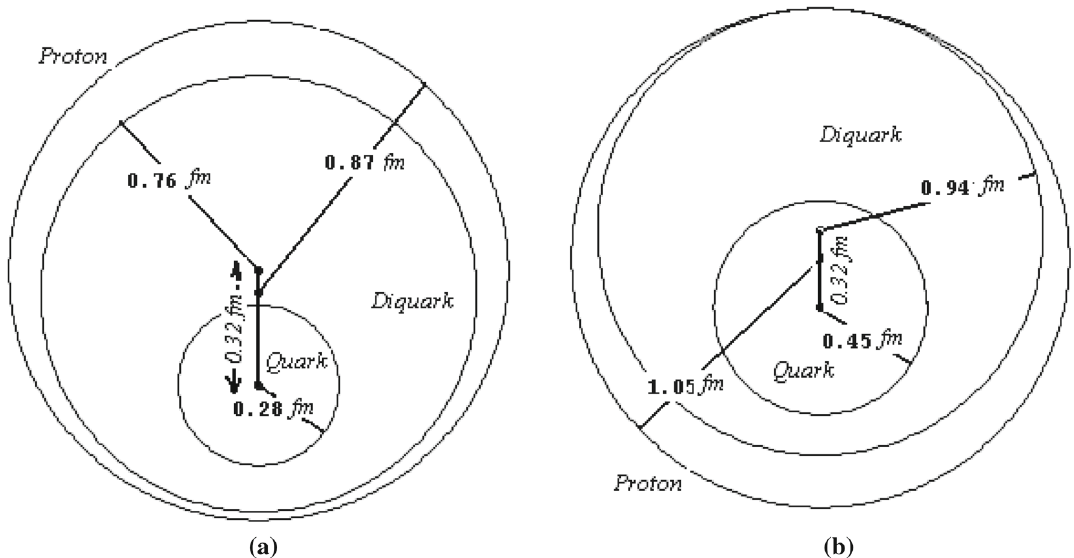
Fig. 4 a and b Represent the proton picture with R q , R d , and R qd values of [15,18], respectively